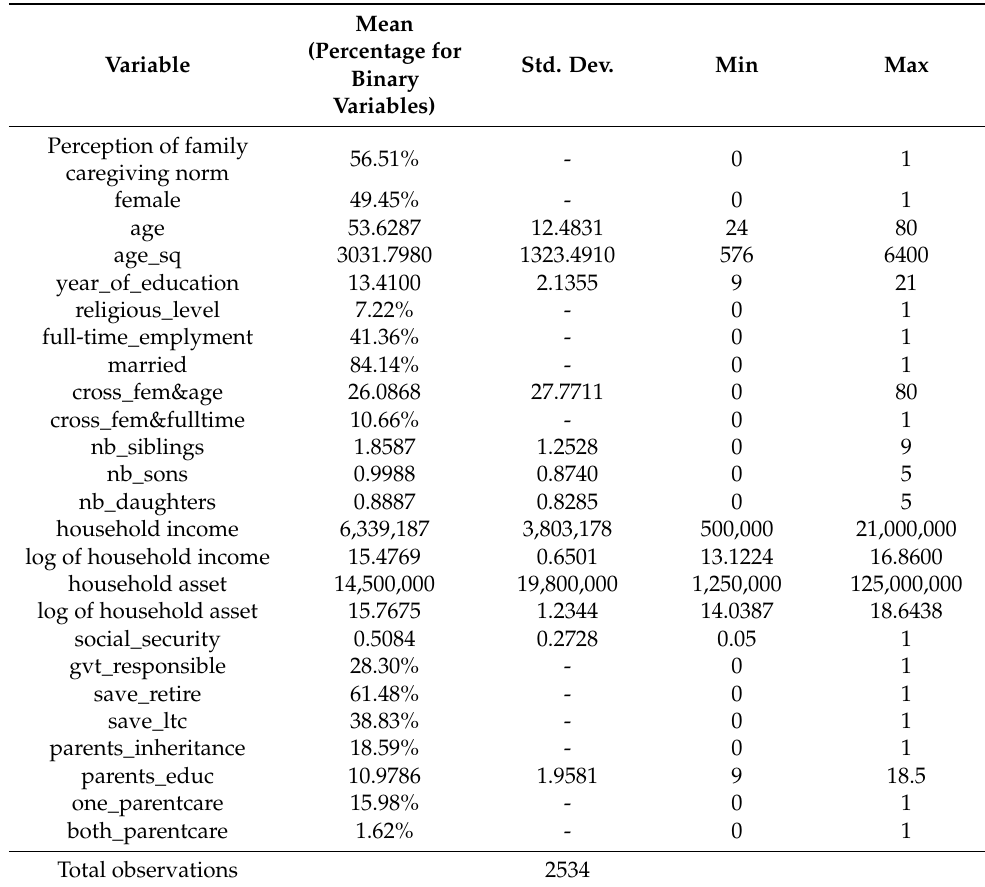
Table 2. Descriptive statistics.